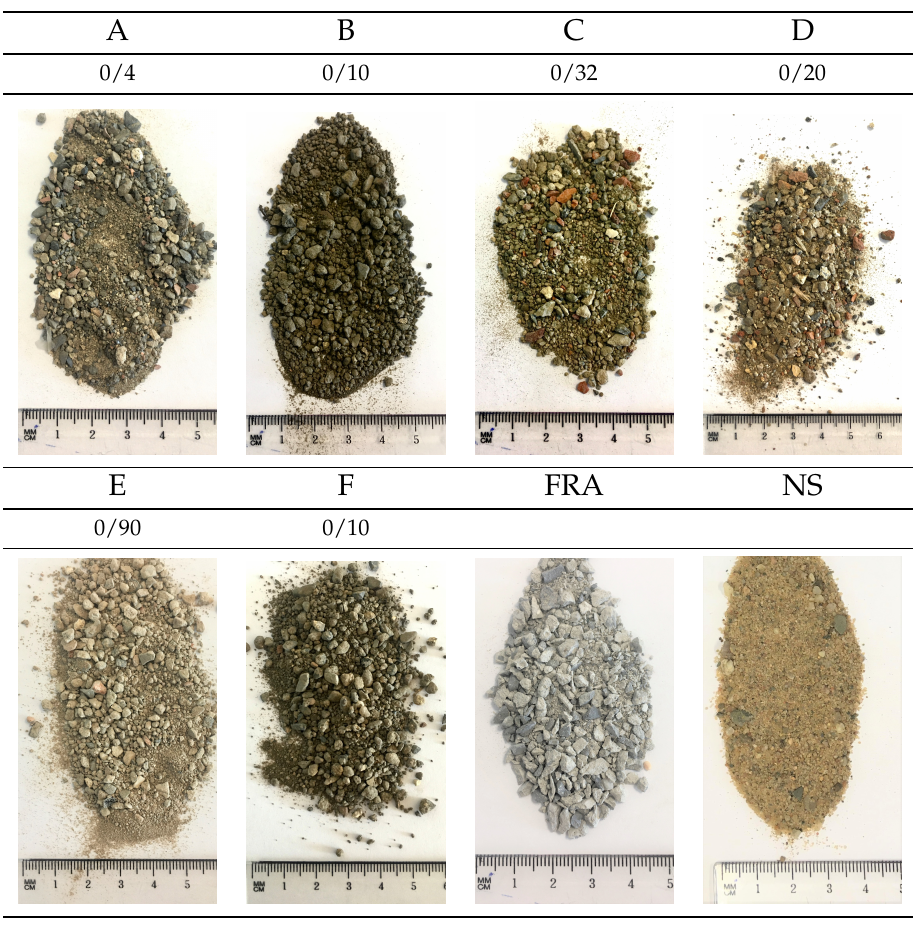
Table 1. The different samples of aggregates and their original size distribution. Pictures shown are after drying at 40 ◦ C and separating of the 0/4 mm fraction. The “model” FRA and natural aggegrate that were used for reference mortars are also